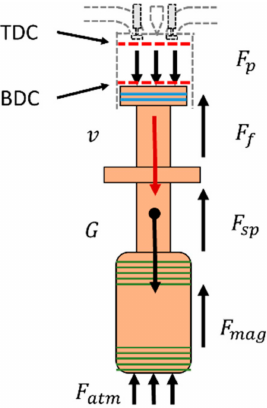
Figure 3. The force analysis of the piston